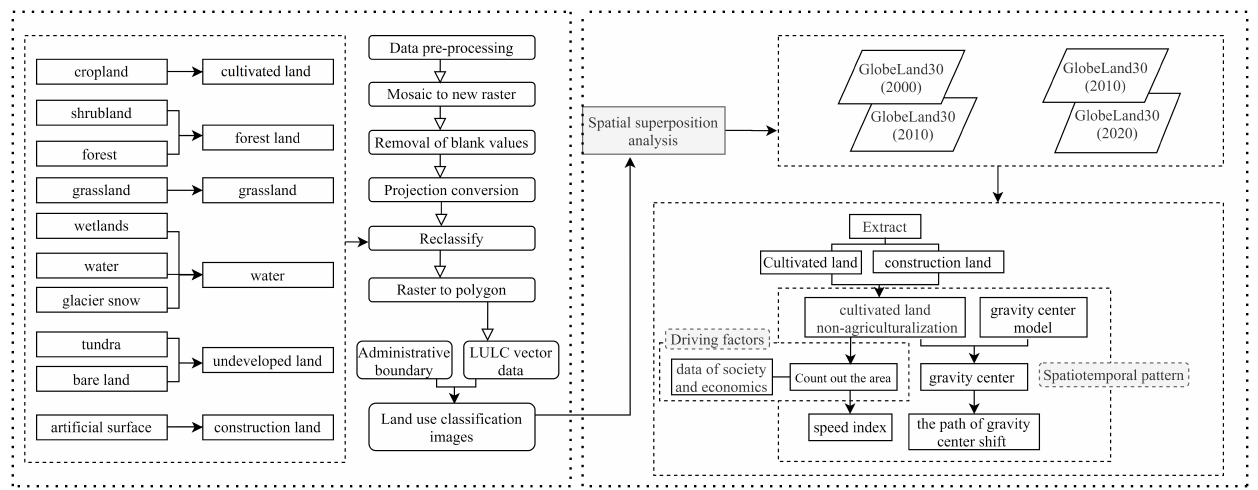
Figure 2. Flow chart of data processing and